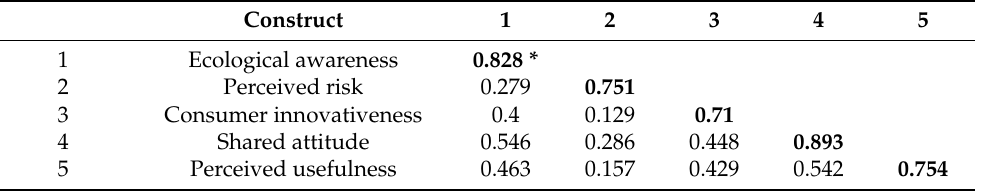
Table 6. Correlation matrix and discriminant validity